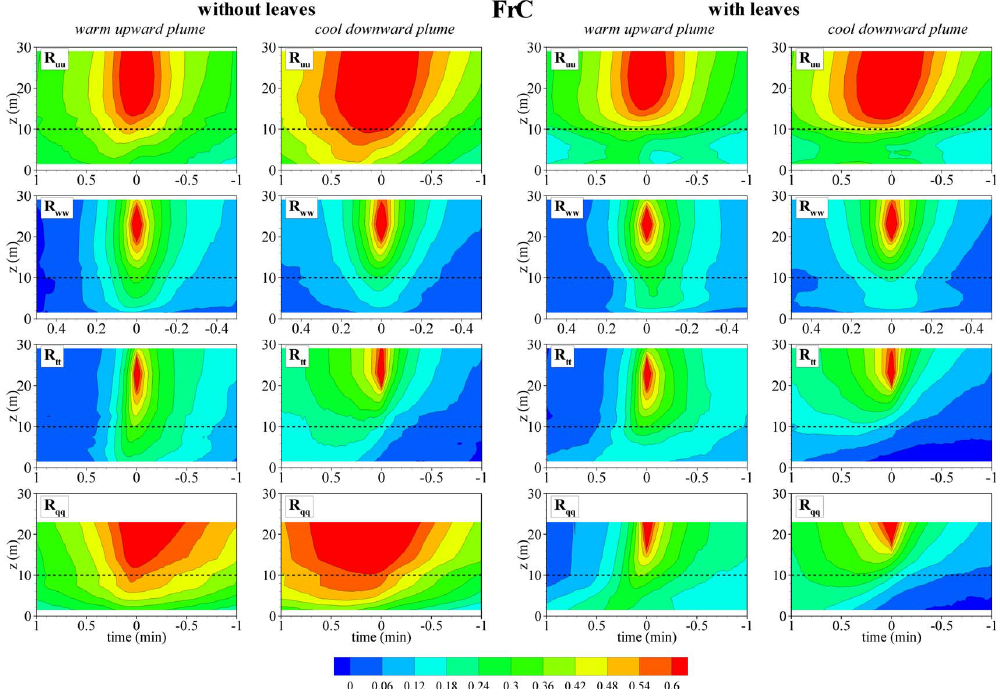
Fig. 6. Autocorrelation contours of u ( R uu ), w ( R ww ), t ( R tt ) and q ( R qq ) associated with warm upward and cool downward plumes referenced to Z = 23m and T = 0min, for free convection (FrC) and for both seasonal periods. The autocorrelations correspond to R 1 | 1 R 3 ϕϕ in Eq. (10), where ϕ is either u , w , t or q . Negative times correspond to times before the structure detection (downwind condition) and positive times to times after the structure detection (upwind condition). The dashed line indicates the canopy